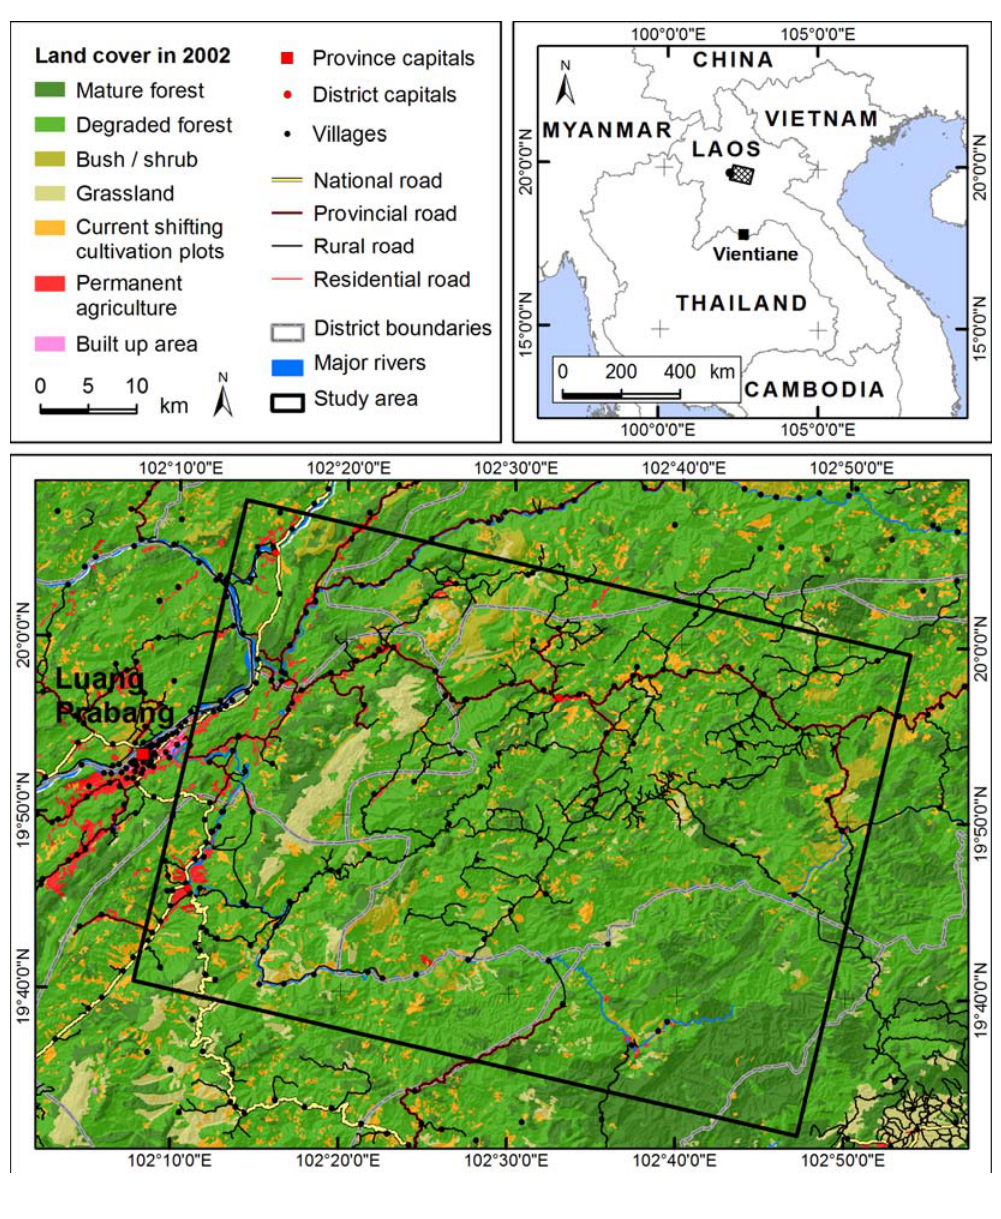
Figure 1. Overview of the study area. Displayed is the 2002 land use/land cover map obtained from the Ministry of Agriculture and Forestry of the Lao